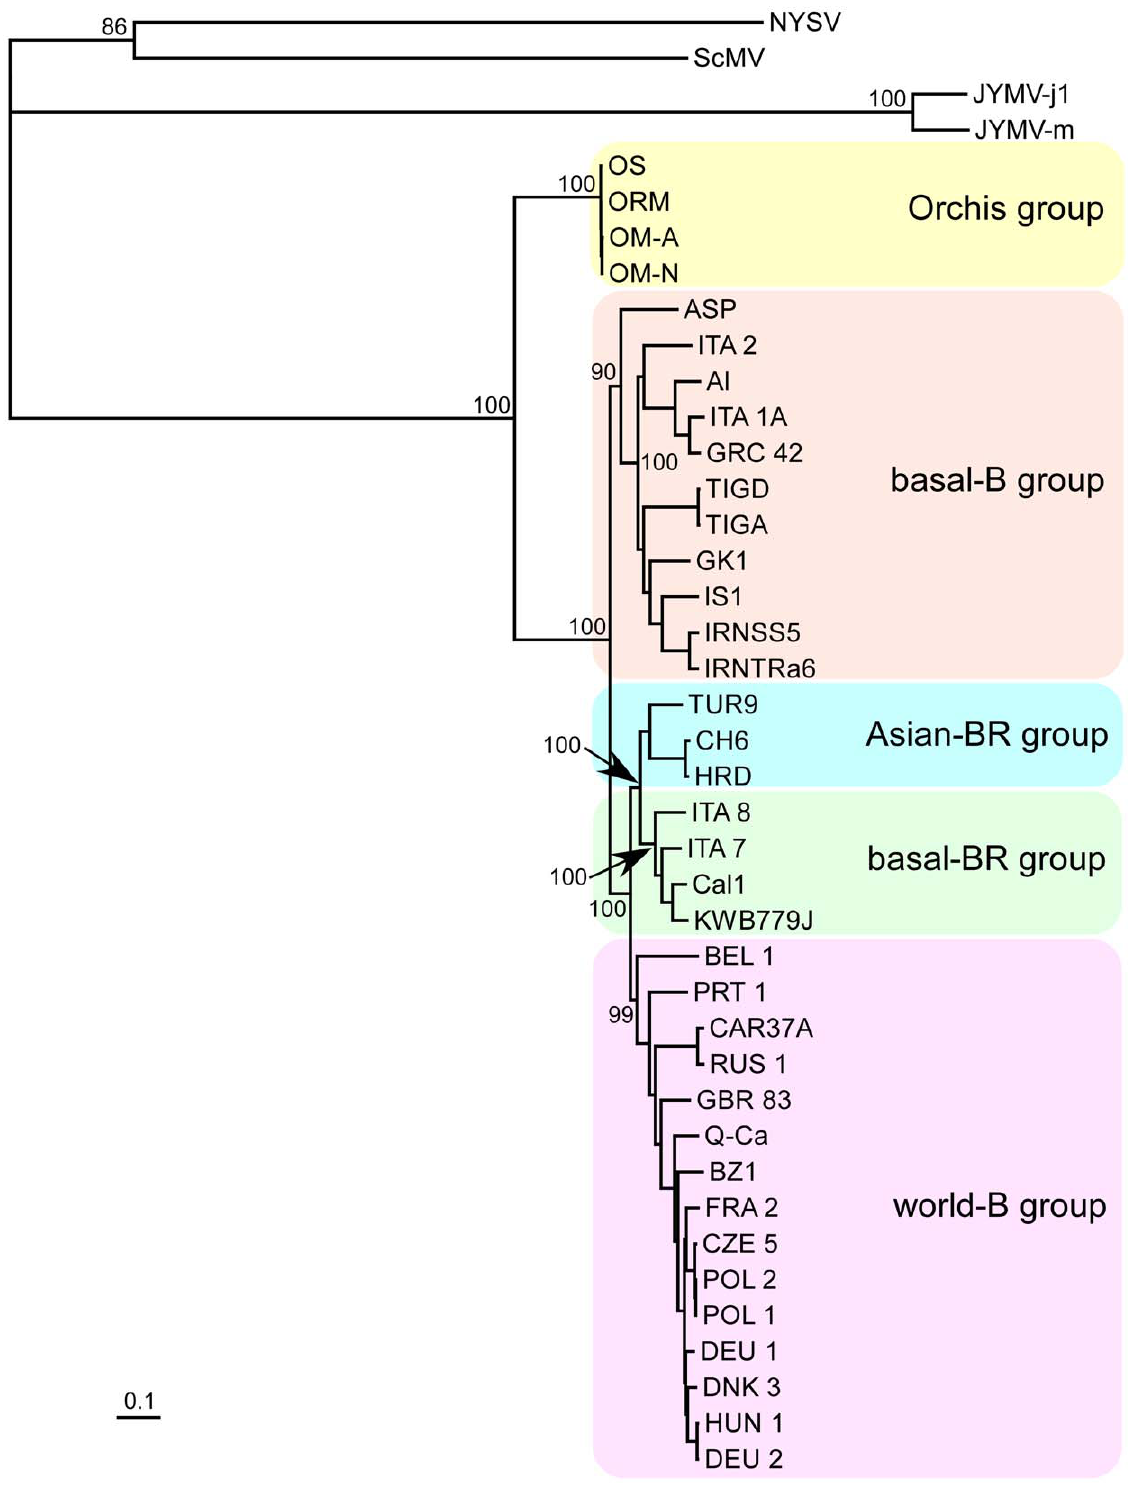
Figure 2. Maximum-likelihood tree of the complete polyprotein sequences of 37 non-recombinant Turnipmosaicvirus isolates. Nodes are labelled with bootstrap support percentages. temporal structure among samples from the genome region from the other genes. This was possibly due to the small size of the encoding the coherently-evolving C-terminal part of the CP, but data set, in terms of both sequence length and sample size. Some this data set still gave TMRCA estimates that differed substantially of the variation in rates among genes might be due to differences